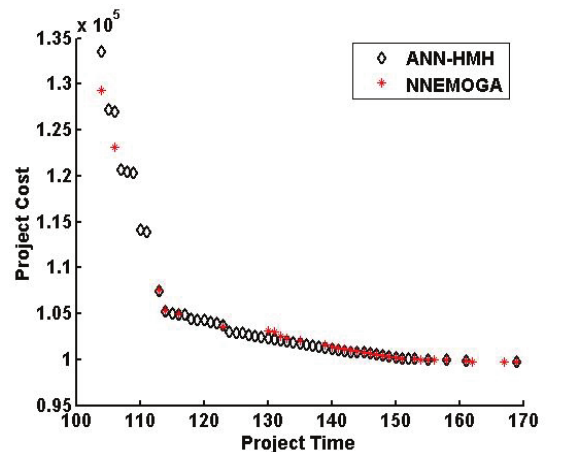
Fig. 15. Tradeoff Points of the final generation population by ANN-HMH and NNEMOGA : Second case